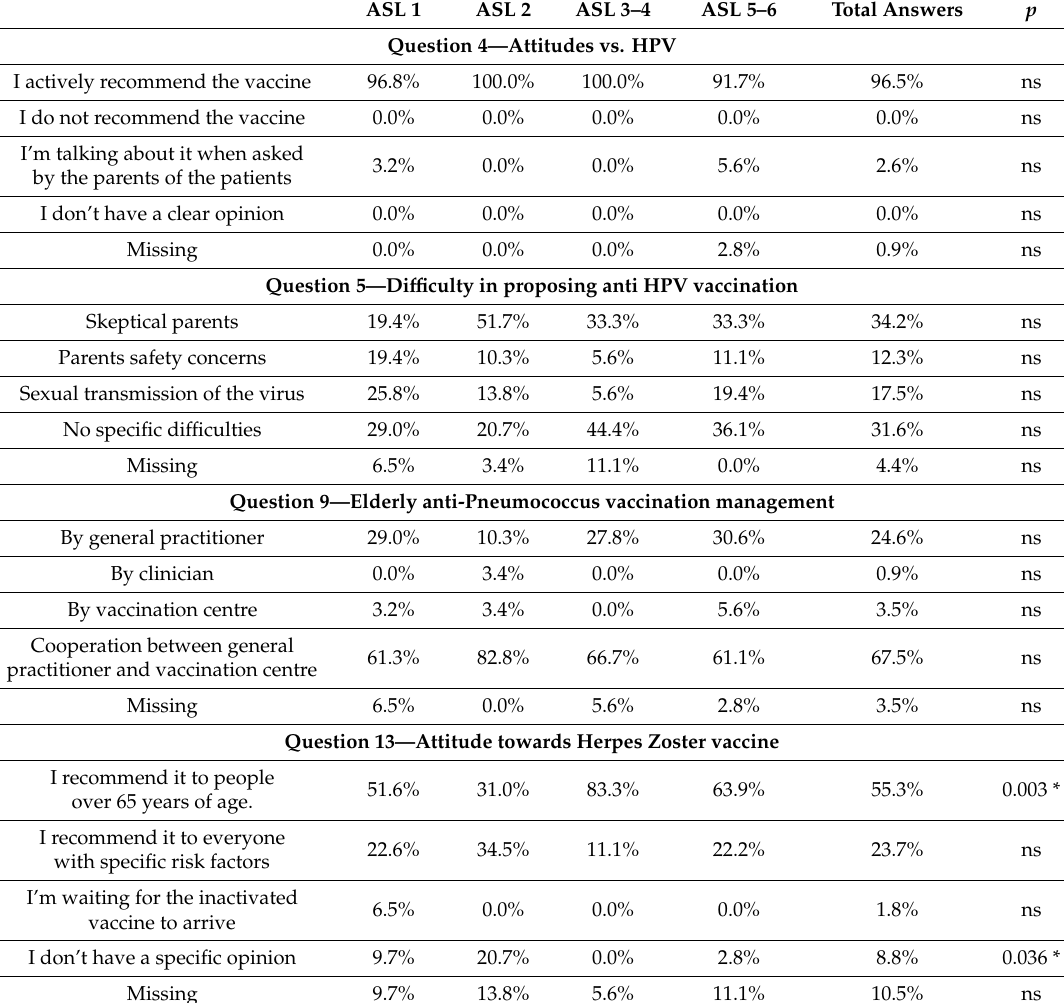
Table 4. Attitude and behaviors questions.